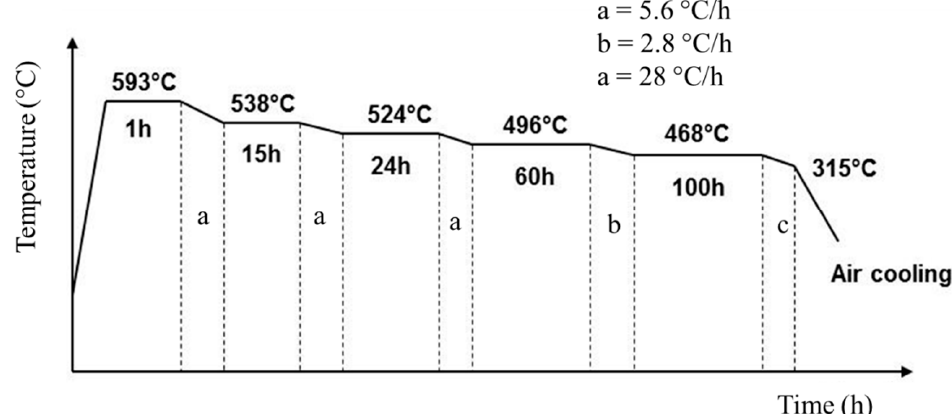
Figure 3. Step cooling heat treatment [14]. Table 3. Testing and characterization.